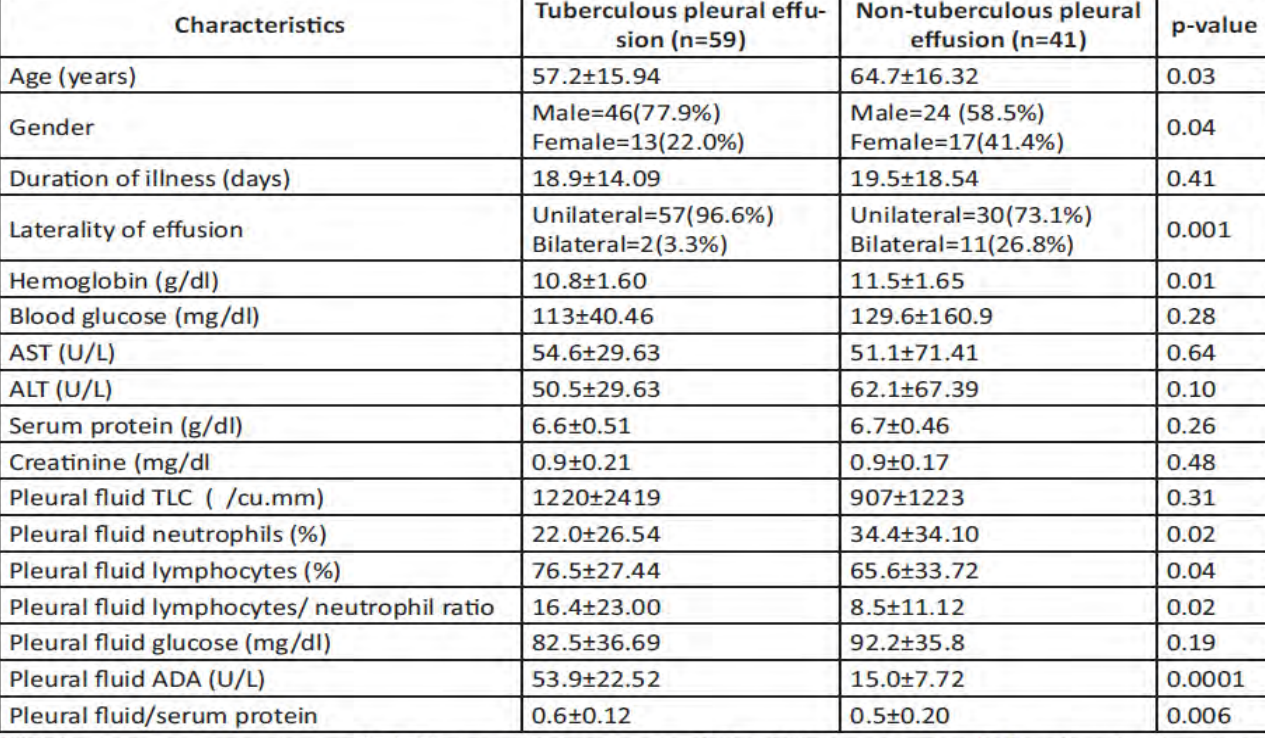
Table 1: Comparison between tuberculous and non-tuberculous pleural